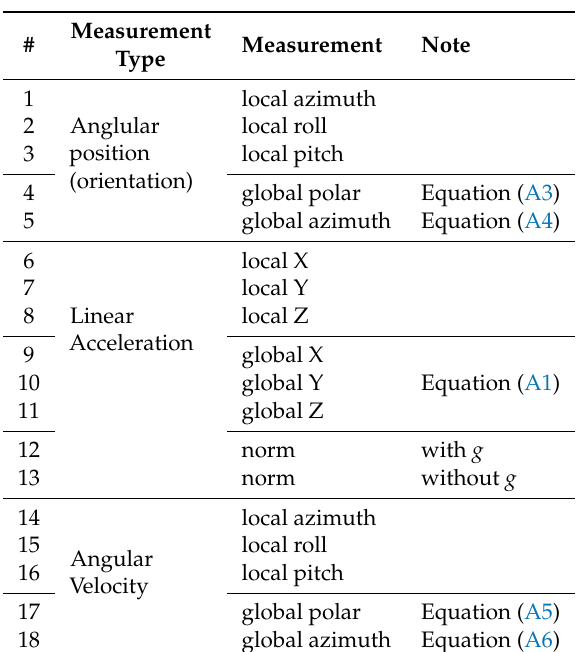
Table 2. Characterization parameters.